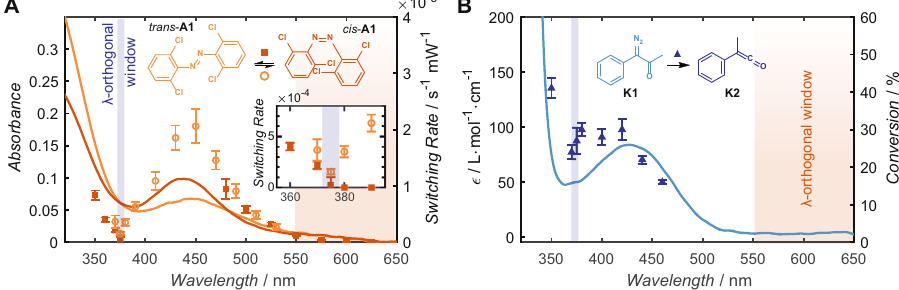
Fig. 2 Orthogonal activation windows. A Wavelength dependent rates of photoisomerization of A1 , normalised to the incident light intensity and overlayed with the absorbance spectra of trans - A1 (dark orange) and cis - A1 (light orange). Switching rates were determined from exponential fi ts to 310 nm absorbance during irradiation. Error bars indicate variation in least squares fi t. Inset highlights switching rates in the λ -orthogonal region from 355 to 395 nm. B Wavelength dependent reaction quantum yield of photoactivated ketene ( K2 ) formation. Conversions determined by 1 H-NMR spectroscopy of K1 to K2 after irradiation with (3.8 ± 0.3) × 10 18 photons of various wavelengths from a 20 Hz tuneable OPO. Error bars determined from standard deviation in pulse energy during